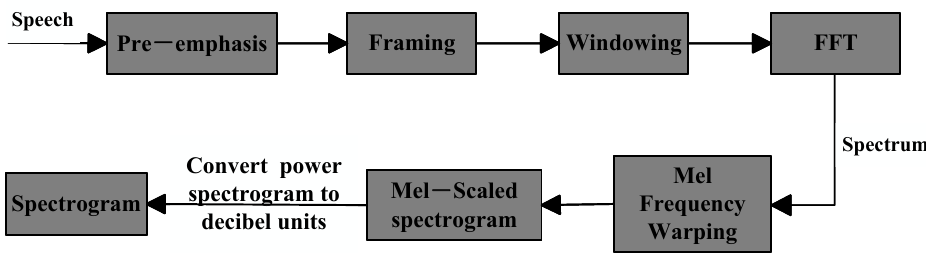
Figure 7. The process of the data preprocessing. The purpose of the preprocessing process is to obtain a spectrogram of the speech signal for further